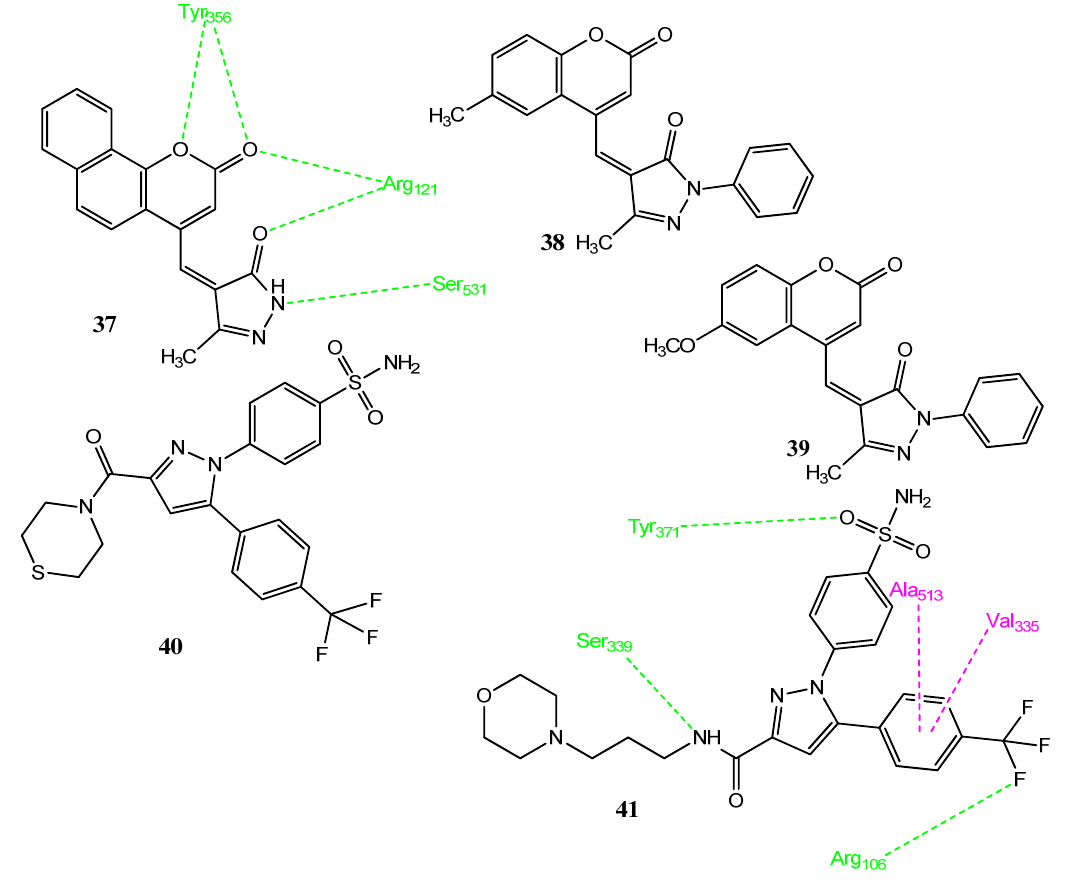
Figure 8. Pyrazole and pyrazolone–based hybrid molecules.